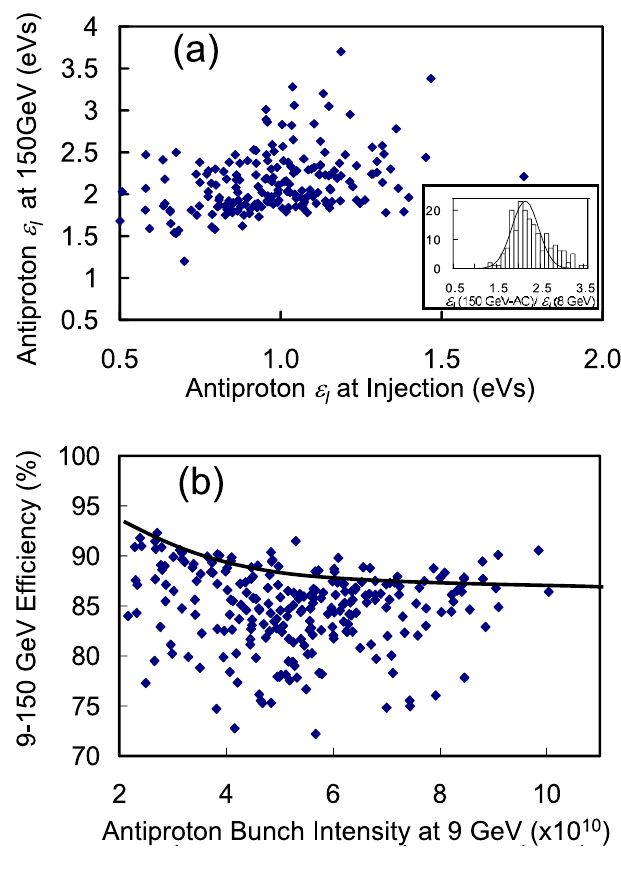
FIG. 1. (Color) (a) Measured average " (90%) for the antipro- l ton bunches in the Main Injector at 150 GeVafter coalescing and before extraction to the Tevatron versus to that at injection for the current acceleration scheme in the Main Injector. (Errors on (cid:8) 15% .) Each point is an average on thirty-six antiproton " l at bunches. The inset is the histogram of the ratio of average " l 150 GeV to that at 9 GeV (2.5 MHz bunches). (b) Measured average injection to extraction antiproton efficiency in the Main Injector versus 2.5 MHz bunch intensity at 9 GeV. The line on (b) represents an average maximum efficiency for a given antiproton intensity at 9 GeV. For other details see the